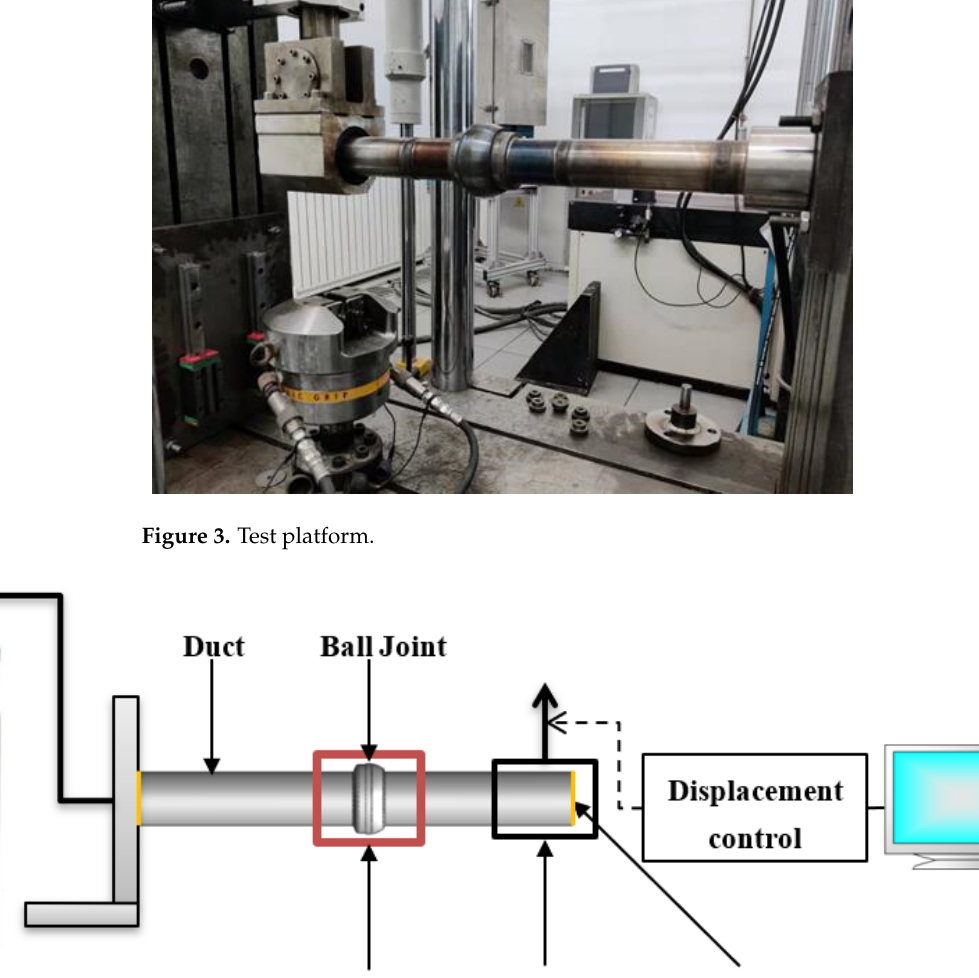
Table 1. Degrees of freedom of a ball joint in different directions.